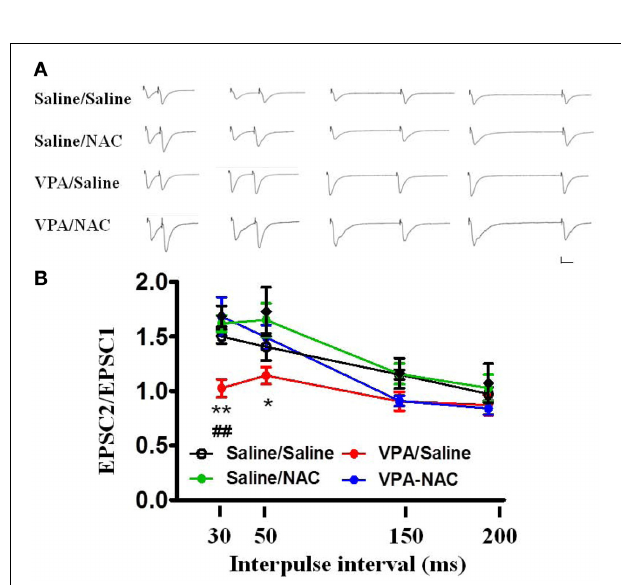
FIGURE 5 | Effects of NAC on the PPF of EPSCs at the thalamo-LA synapses of the VPA-exposed offspring. (A) Sample traces of the PPF of EPSCs taken from slices of Saline/Saline, Saline/NAC, VPA/Saline, and VPA/NAC rats. Sample traces were the average of 3–5 successive responses. Calibration; 50 pA, 30ms. (B) Plot of the PPF in the Saline/Saline, Saline/NAC, VPA/Saline, and VPA/NAC rats. ∗ p < 0 . 05, ∗∗ p < 0 . 01 vs. VPA/saline. ## p < 0 . 01 vs. Saline/Saline.